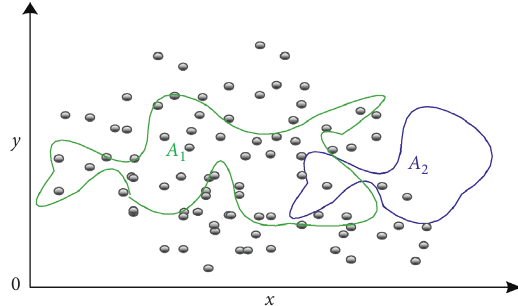
Figure 5: Schematic diagram of the feasible domain for the so- lution of a two-dimensional optimization problem.